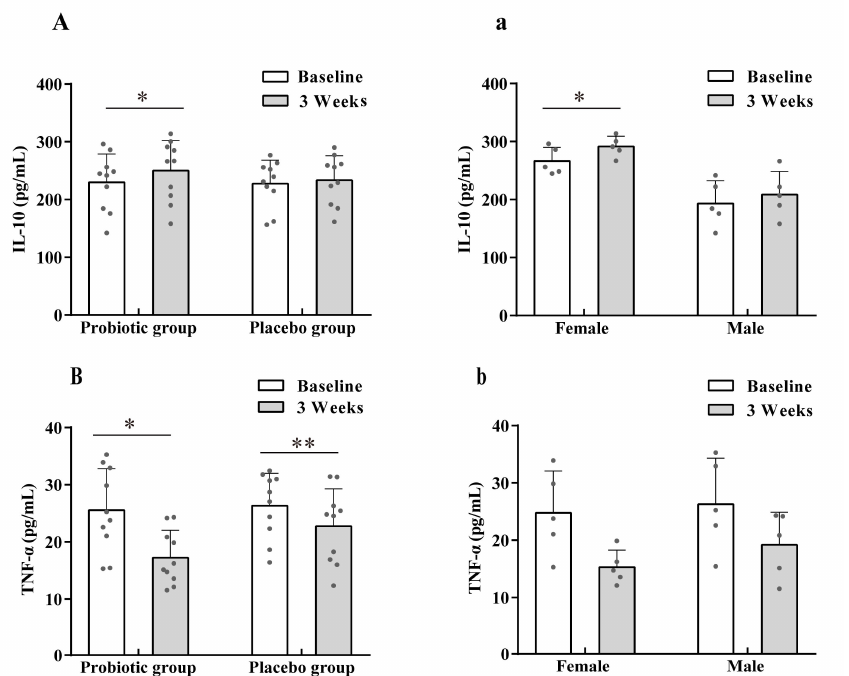
Figure 3. Effect of LTL1879 on inflammatory factors interleukin-10 (IL-10) and tumor necrosis factor- α (TNF- α ). ( A ) Serum IL-10 levels in volunteers. ( B ) Serum TNF- α levels in volunteers. ( a ) Serum IL-10 levels in the probiotics group. ( b ) Serum TNF- α levels in the probiotics group volunteers. Data are shown as means standard deviations (SD). Asterisks indicate significant differences (paired t -test, * p < 0.05, ** p < 0.01). n = 10 or n = 5 volunteers per